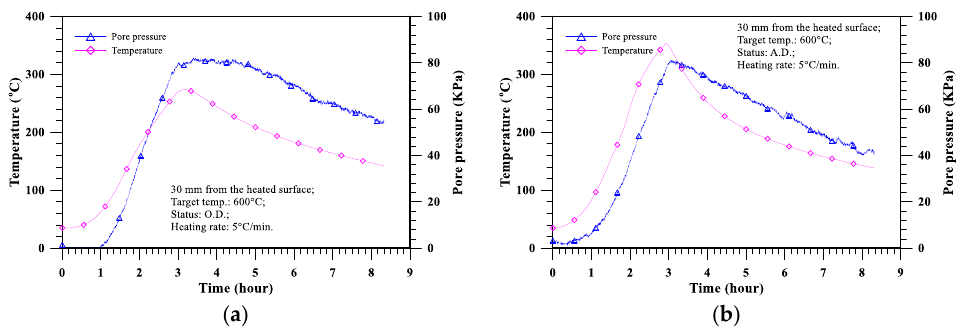
Figure 14. The evolution with time of the temperature and pore pressure at a depth of 30 mm from the heated surface of the LWAC slab at a target temperature of 600 °C and a heating rate of 5 °C/min: ( a ) oven-dried state; ( b ) air-dried state.